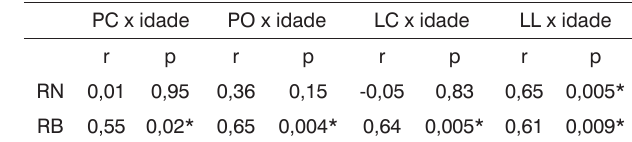
Tabela 1. Correlação entre postura e